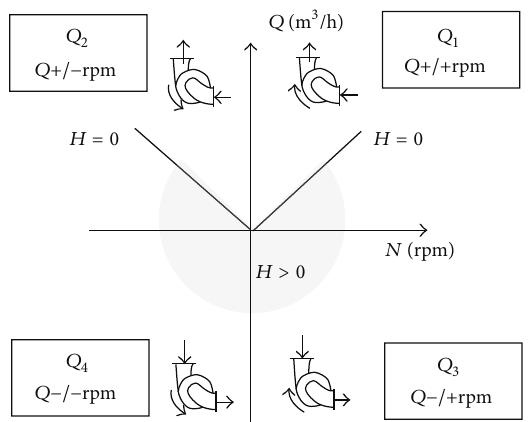
Figure 1: The four-quadrant representation: operating zones where 𝐻 > 0